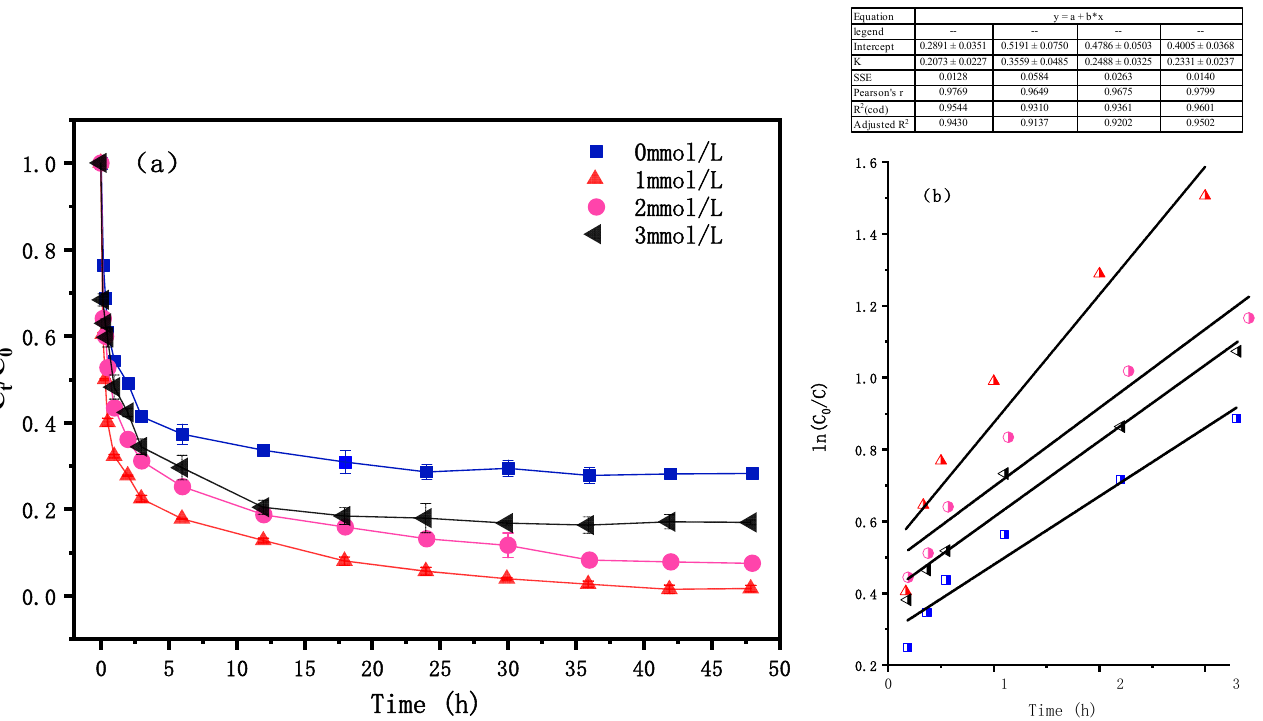
Figure 8. Effect of PS dosage on degradation curve and linear fitting. PNP degradation curves with different PS concentrations ( a ), Dynamic fitting curve ( b ).